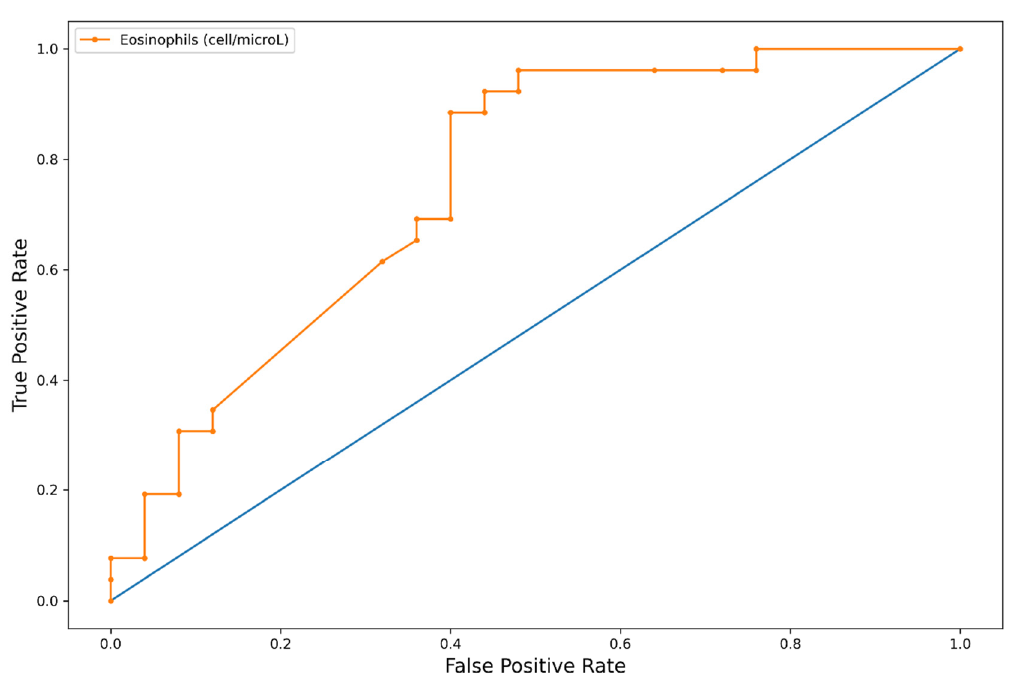
Figure 3. ROC curves with PNS involvement as the dependent variable and the eosinophil count as the independent variable.